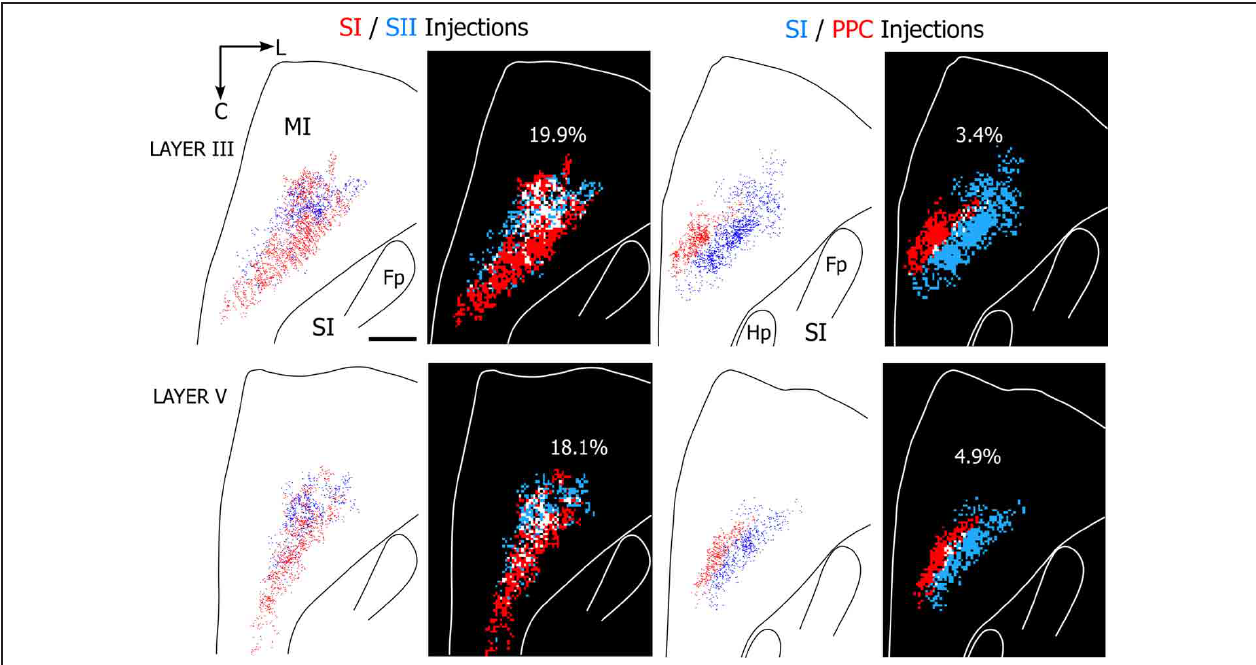
or V. For each section, the plotted reconstructions of the labeled terminals were subdivided into square bins (50 μ m 2 ) color-coded by whether the bin contains terminal projections from one injection site (blue or red) or overlapping projections from both injections (white). Amount of overlap in each section is indicated by percentages. Scale bar = 1mm. Abbreviations: HP, hindpaw; FP, forepaw.